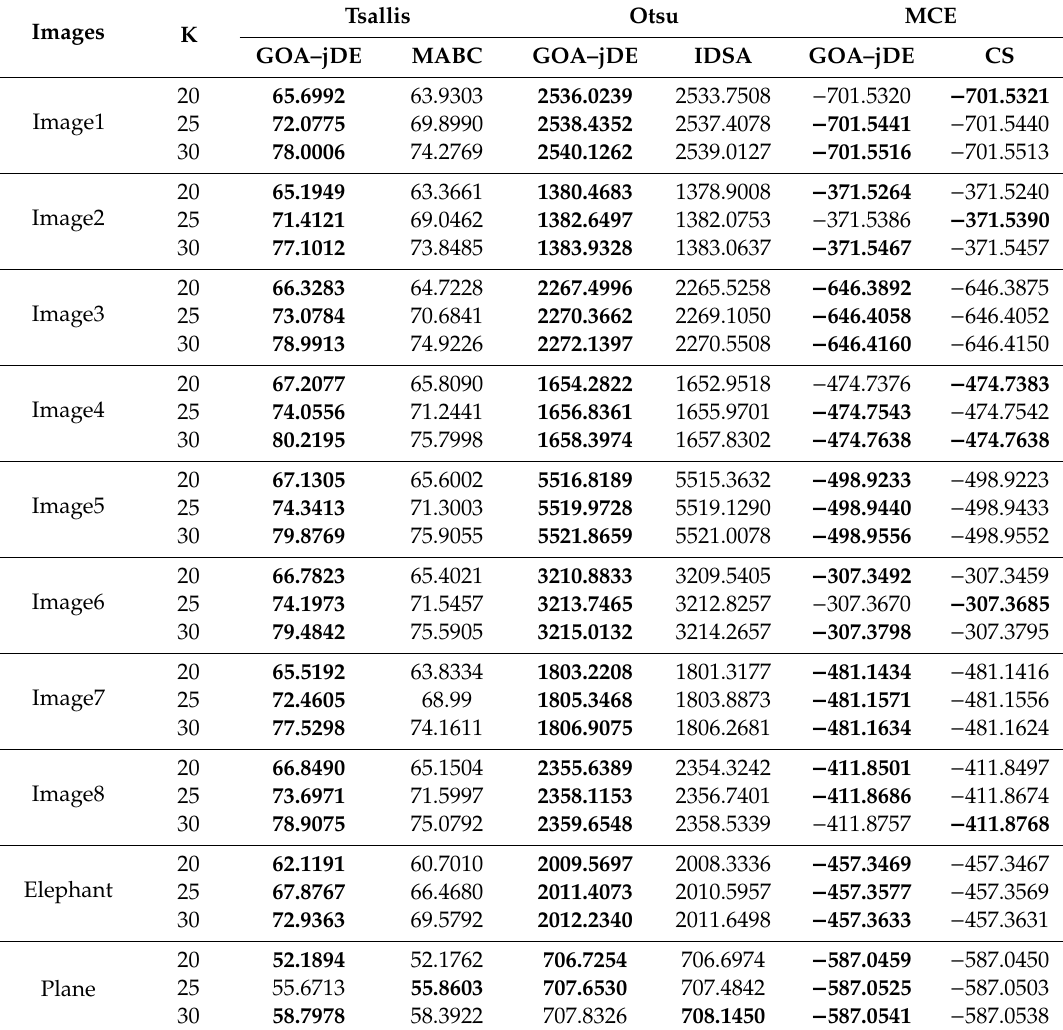
Table 11. Average objective function value obtained using Tsallis entropy, Otsu’s method, and